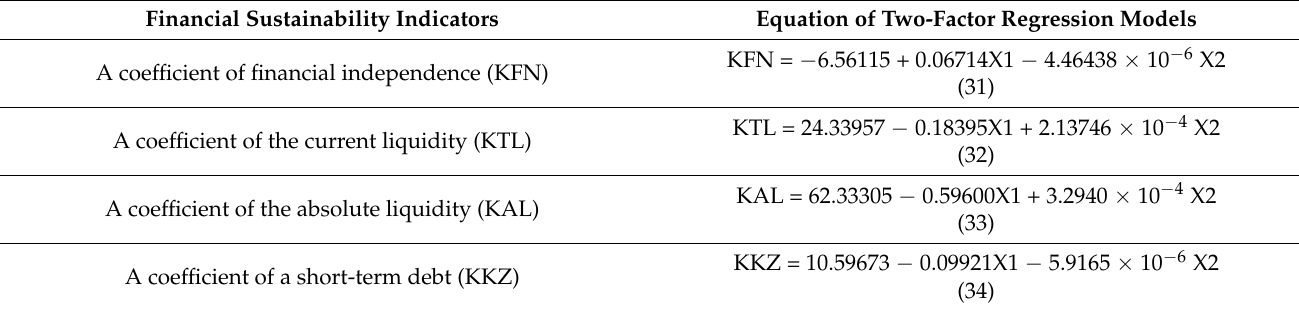
Table 8. Results of creating two-factor regression models of the dependency of a company’s financial sustainability indicators.